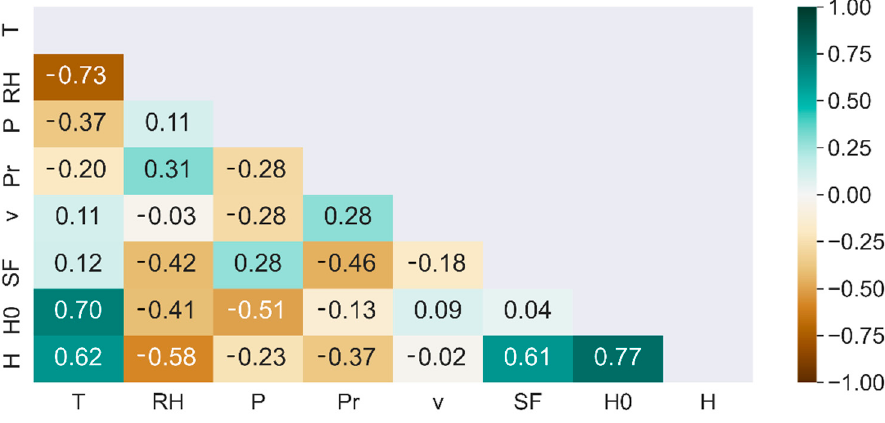
Figure 3. Triangular correlation heatmap of the studied variables.